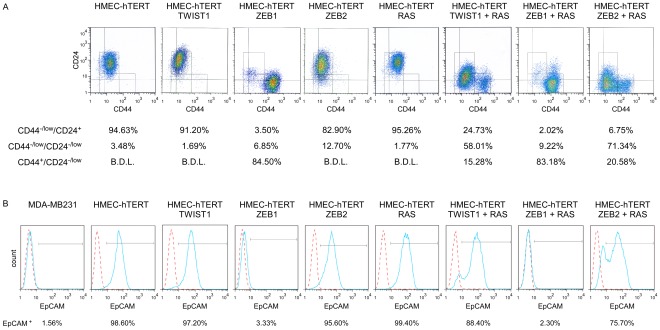
Combined expression of H-RASG12V and EMT–inducing transcription factors provides HMEC cells with a stem cell–like antigenic phenotype.Analysis by flow cytometry of the expression of CD44, CD24 (A) and EpCAM (B). Solid blue lines represent staining with FITC-anti-EpCAM antibody and dotted red lines represent staining with FITC-conjugated isotype control. B.D.L.: Below Detection Limit. The claudin-low mesenchymal breast cancer cell line MDA-MB231 was used as a negative EpCAM staining control.